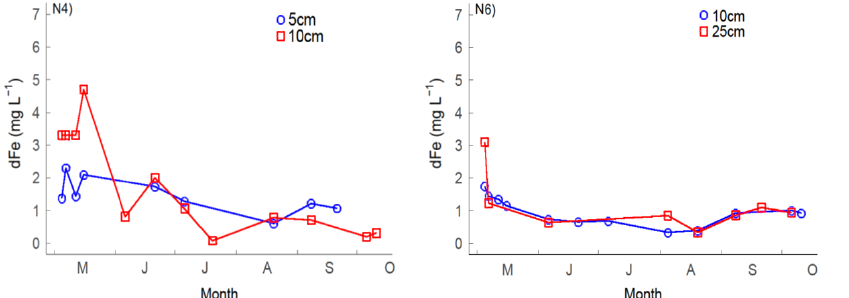
Figure 6. Seasonal changes in dFe concentrations in surface soil pore waters at N4 and N6, observed from the snowmelt